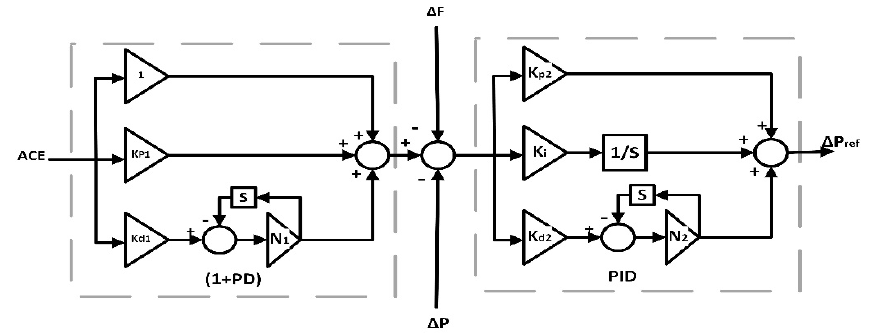
Figure 4. The configuration of the proposed (1+PD)-PID cascaded controller.